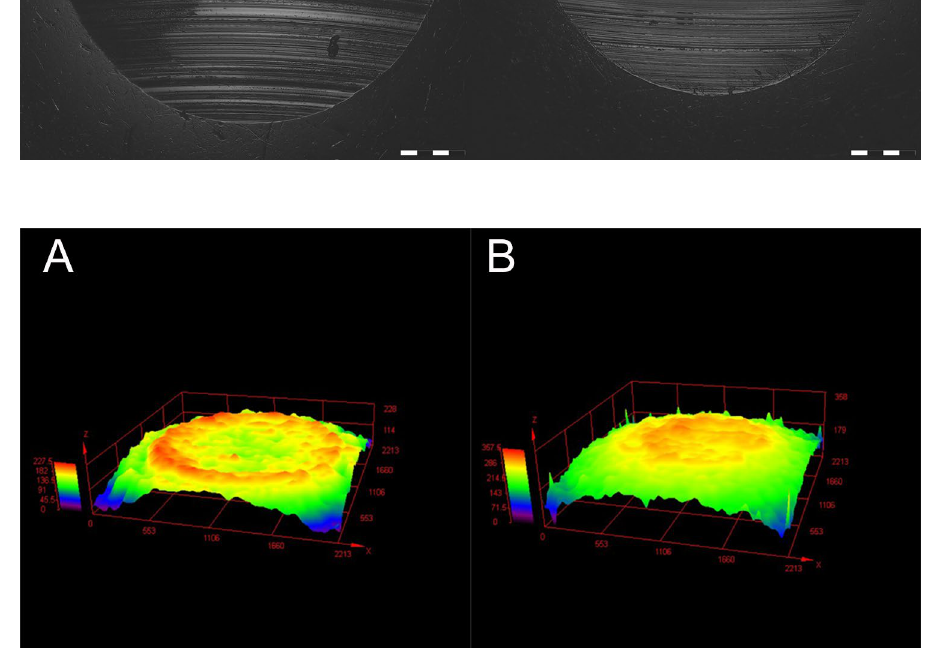
Fig.11 3D profile of worn surface of steel ball, a paraffin liquid, b CuO@BNNS